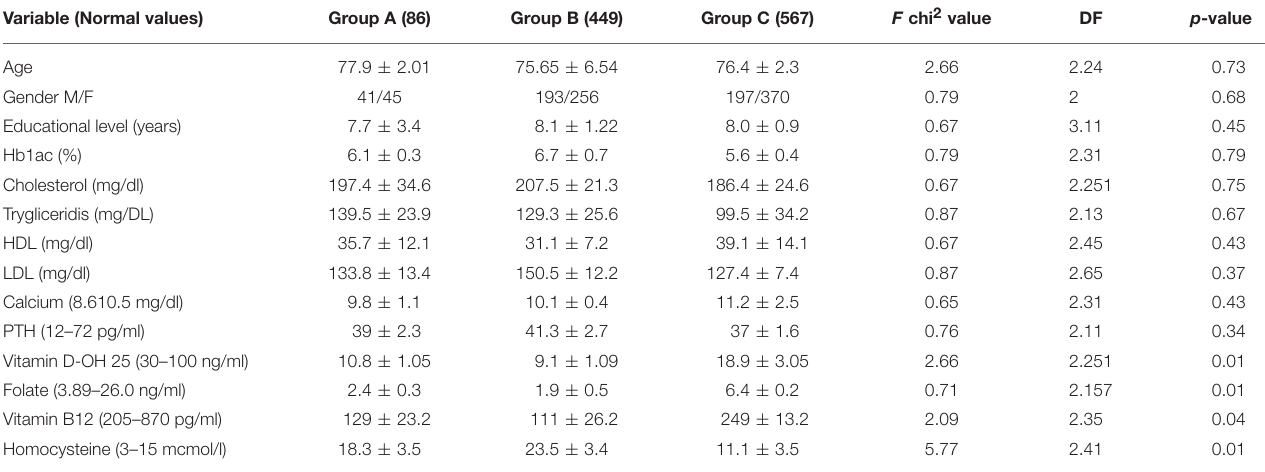
TABLE 2 | Comparison of mean value of age, gender, educational level, various biochemical parameters in AD, sVAD, and controls. Variable (Normal